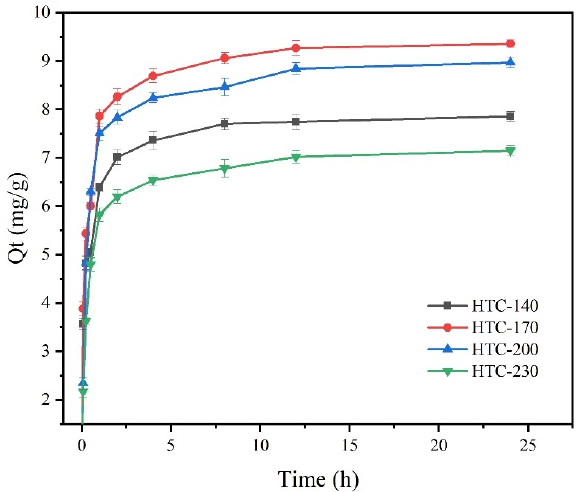
Figure 10. The effect of adsorption time on the adsorption of Cd 2+.